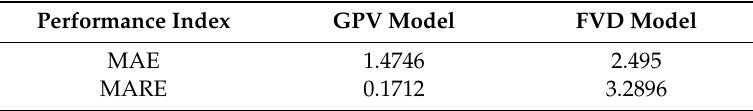
Table 3. Evaluation Results of the parameter calibrations.